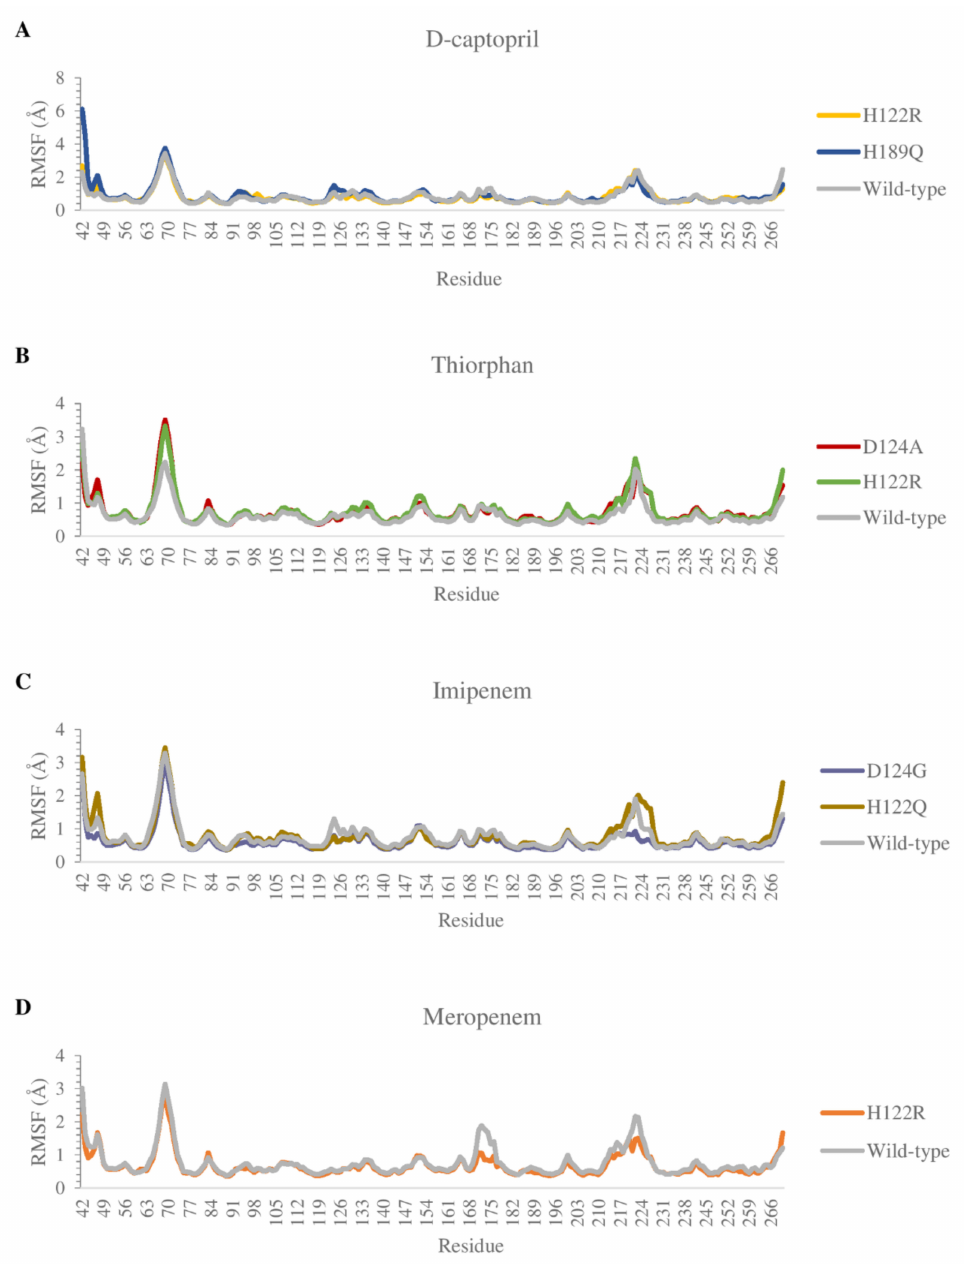
Figure 8. Carbon alpha RMSF values of the mutants and the wild type in complex with 4 ligands during MD simulations. ( A ) D-captopril. ( B ) Thiorphan. ( C ) Imipenem. ( D )